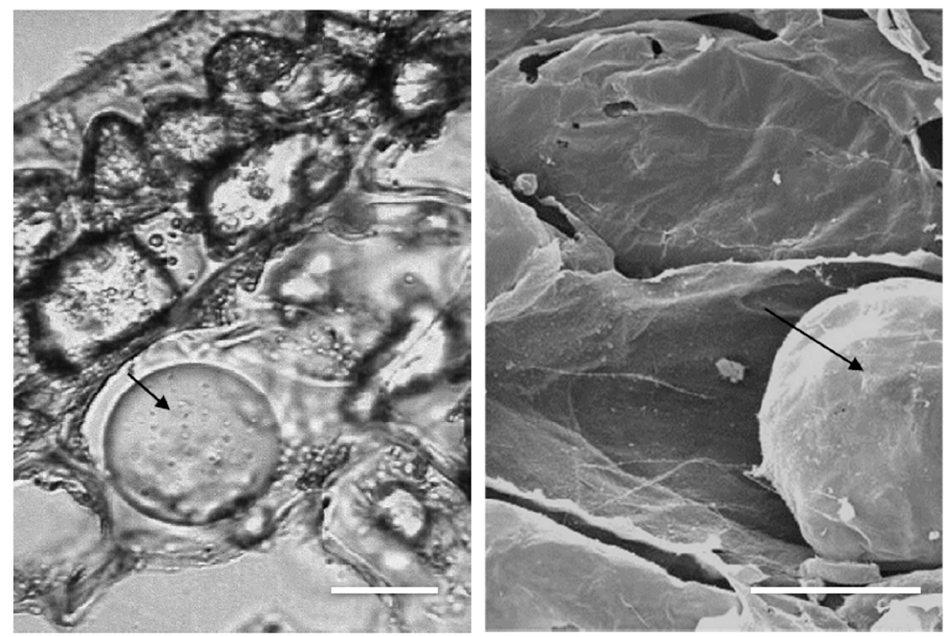
Figure 5 . Olive mesocarp cells with oil droplets (arrows) by ( left ) light microscopy and ( right ) scanning electron microscopy. Bars = 30 μ m.